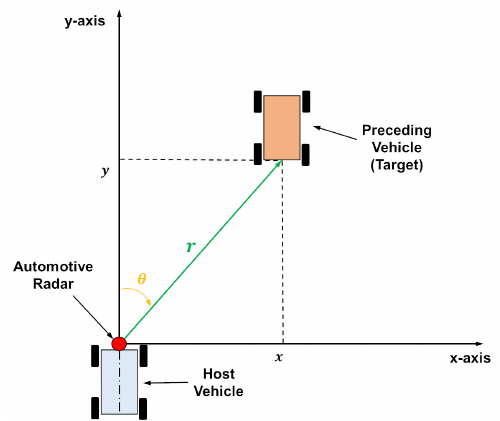
Figure 1. Automotive radar